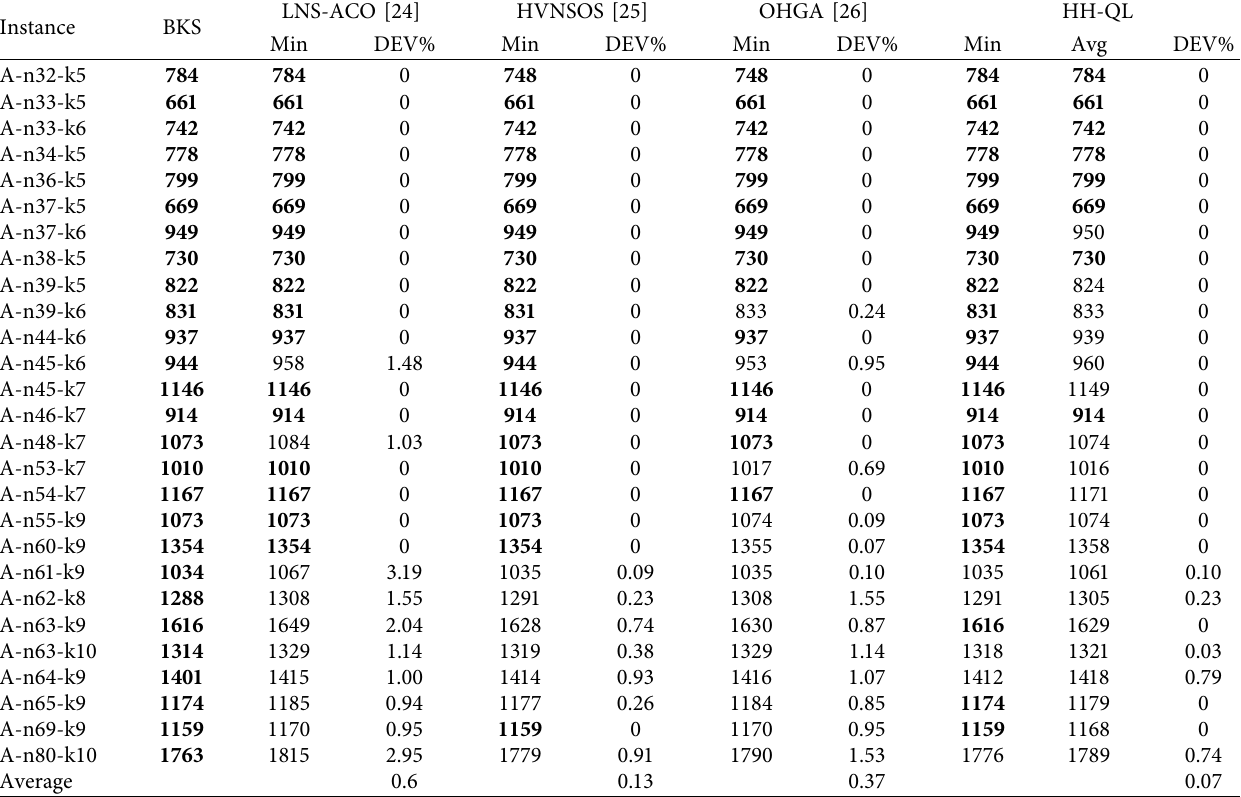
Table 2: CVRP set A standard instance test